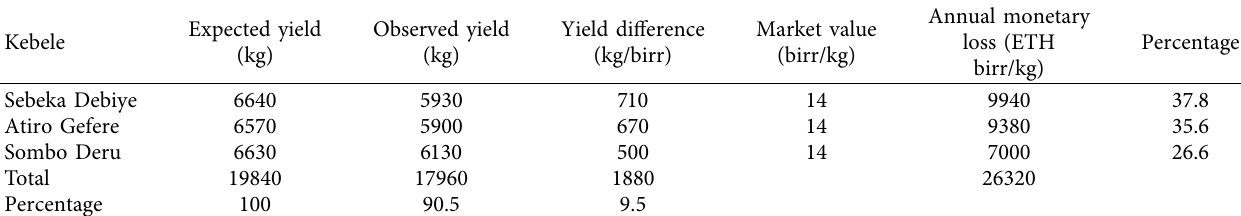
Table 9: Te amount of maize yield loss in terms of the market value caused by the grivet monkey.